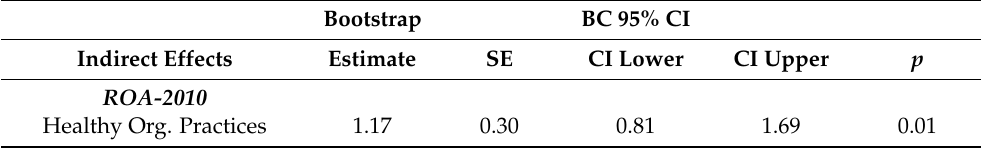
Table 6. Bootstrapping for healthy organizational practices, vertical trust, and ROA-2010 mediation model aggregated data (N = 31 companies).